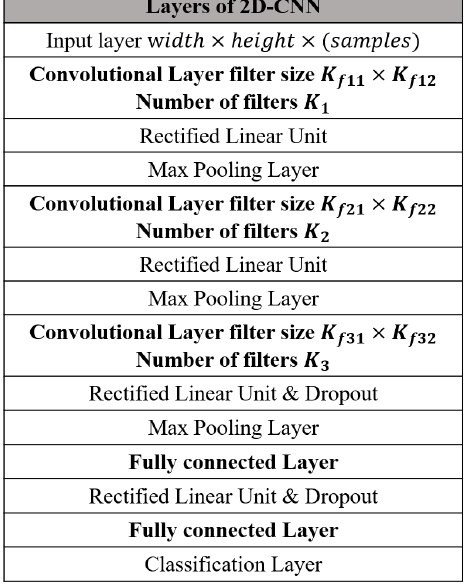
Figure 2. CNN module for handwriting character